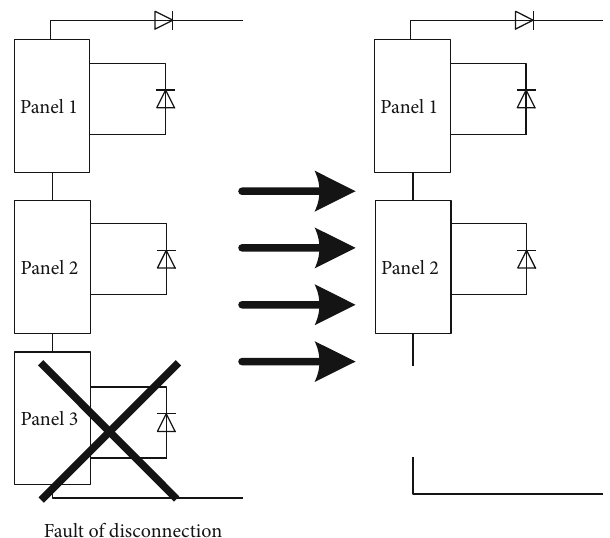
Figure 8: Disconnecting of a PV panel and the relevant bypass